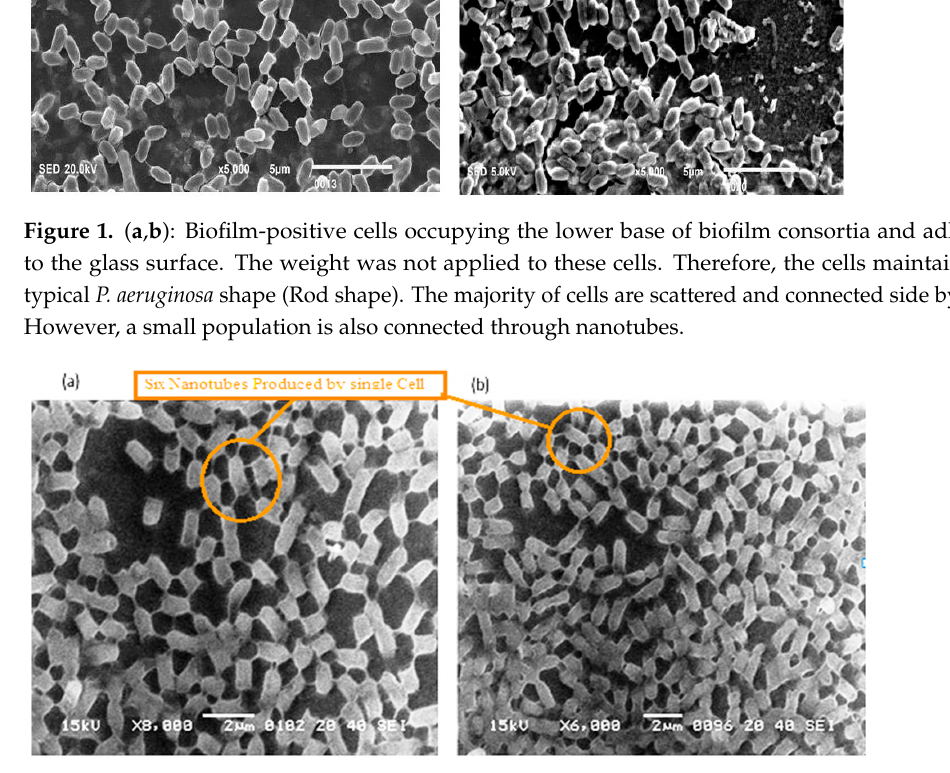
Figure 3. The 3Drepresentation of biofilm-positive cells occupying the lower base of biofilm con- sortia and adhered to the glass surface. The weight was not applied to these cells, therefore, the cells maintained typical P. aeruginosa morphology i.e. rod shape. ( a ): Cells with normal P. aeru- ginosa morphology. ( b ): In this 3D image, the formation of nanotubes can be visualized connecting surface-attached cells of adherent biofilms. ( c ): cells connected Side by side as well as through nanotube. ( d ): Extracellular matrix material attached to the cell surface.